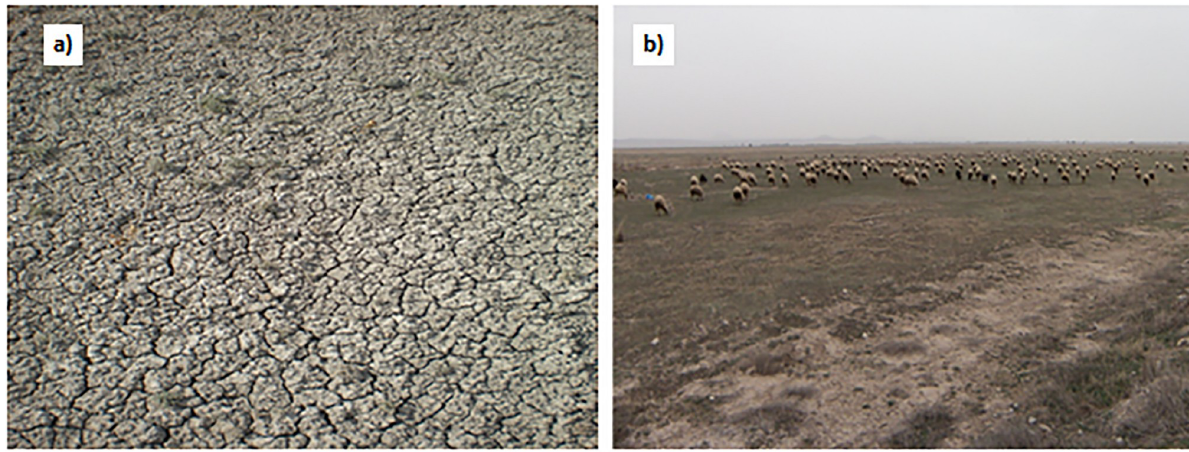
Fig 4. Sodium slickspot (a) and overgrazing in the study area (b). (Pictures taken by Mesut Budak).